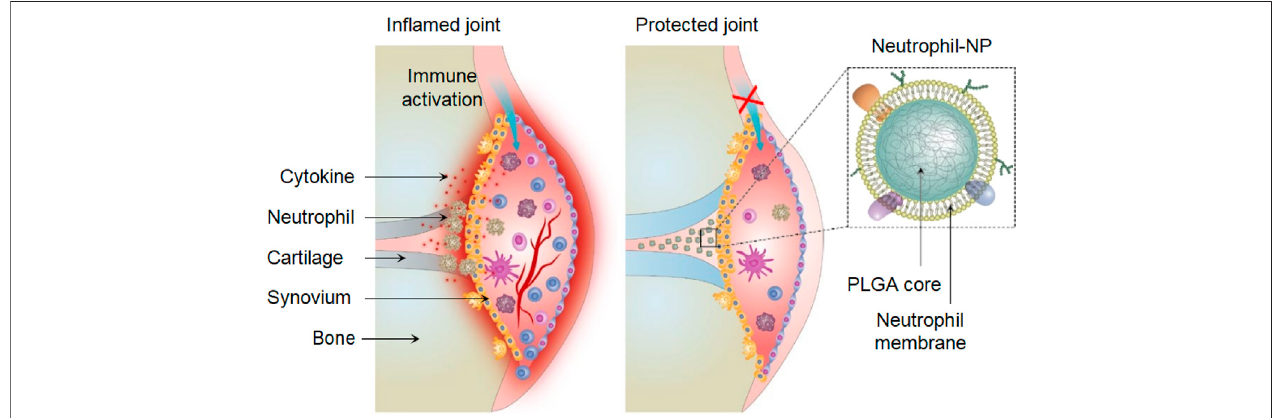
FIGURE 9 | Neutrophil-NPs inhibit synovial in fl ammation and ameliorate joint destruction in in fl ammatory arthritis (Reproduced from Zhang Q. et al., 2018).